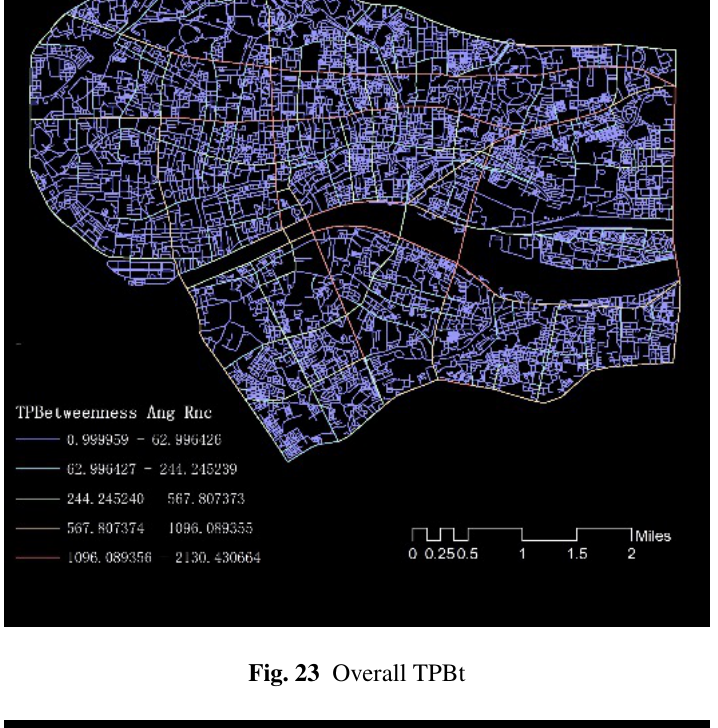
Fig. 23 Overall TPBt